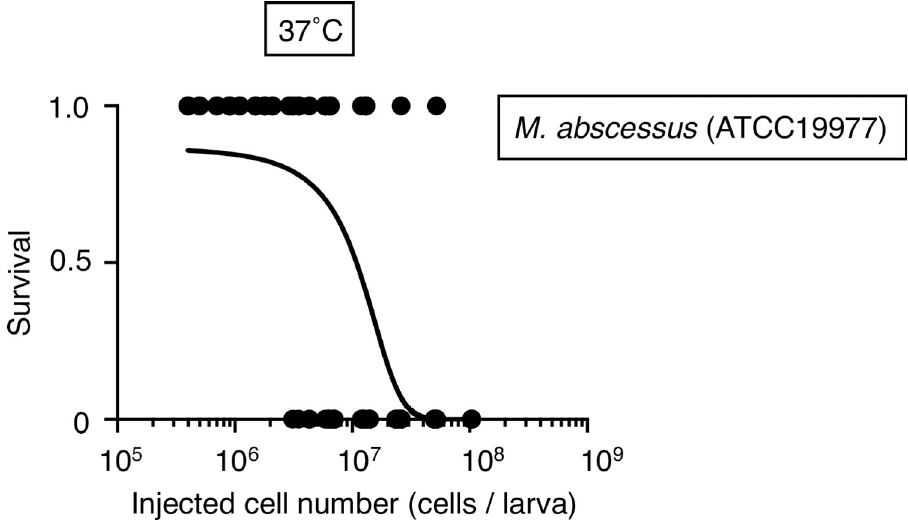
Fig 2. Determination of the M . abscessus subsp. abscessus ATCC19977 LD 50 in silkworms. Silkworms were injected with saline (50 μ l) or M . abscessus subsp. abscessus ATCC19977 cell suspension (4 x 10 5 –1 x 10 8 cells per 50 μ l) and incubated at 37˚C for 2 days. The numbers of live and dead silkworms are indicated as 1 and 0, respectively. The curve represents data from 6 independent experiments combined in a simple logistic regression model. One hundred twenty-nine silkworms were used in the